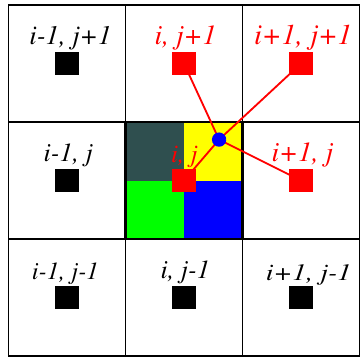
Figure 11. Two-dimensional example of the optimized interpola- tion algorithm. Interpolating a scalar quantity (e.g., temperature) bi-linearly on a particle (blue dot) located in a certain LES grid box (thick black line) includes four values of LES data (red squares). Note that these values are the same for all particles located in the yellow subgrid box. Thus, by sorting all particles inside a grid box by their respective subgrid box, the indices required for interpola- tion need to be determined just once for all particles located in that subgrid box, and not repeatedly for all particles inside the entire grid box. This algorithm applies analogously for the velocity com- ponents located at the edges of the grid